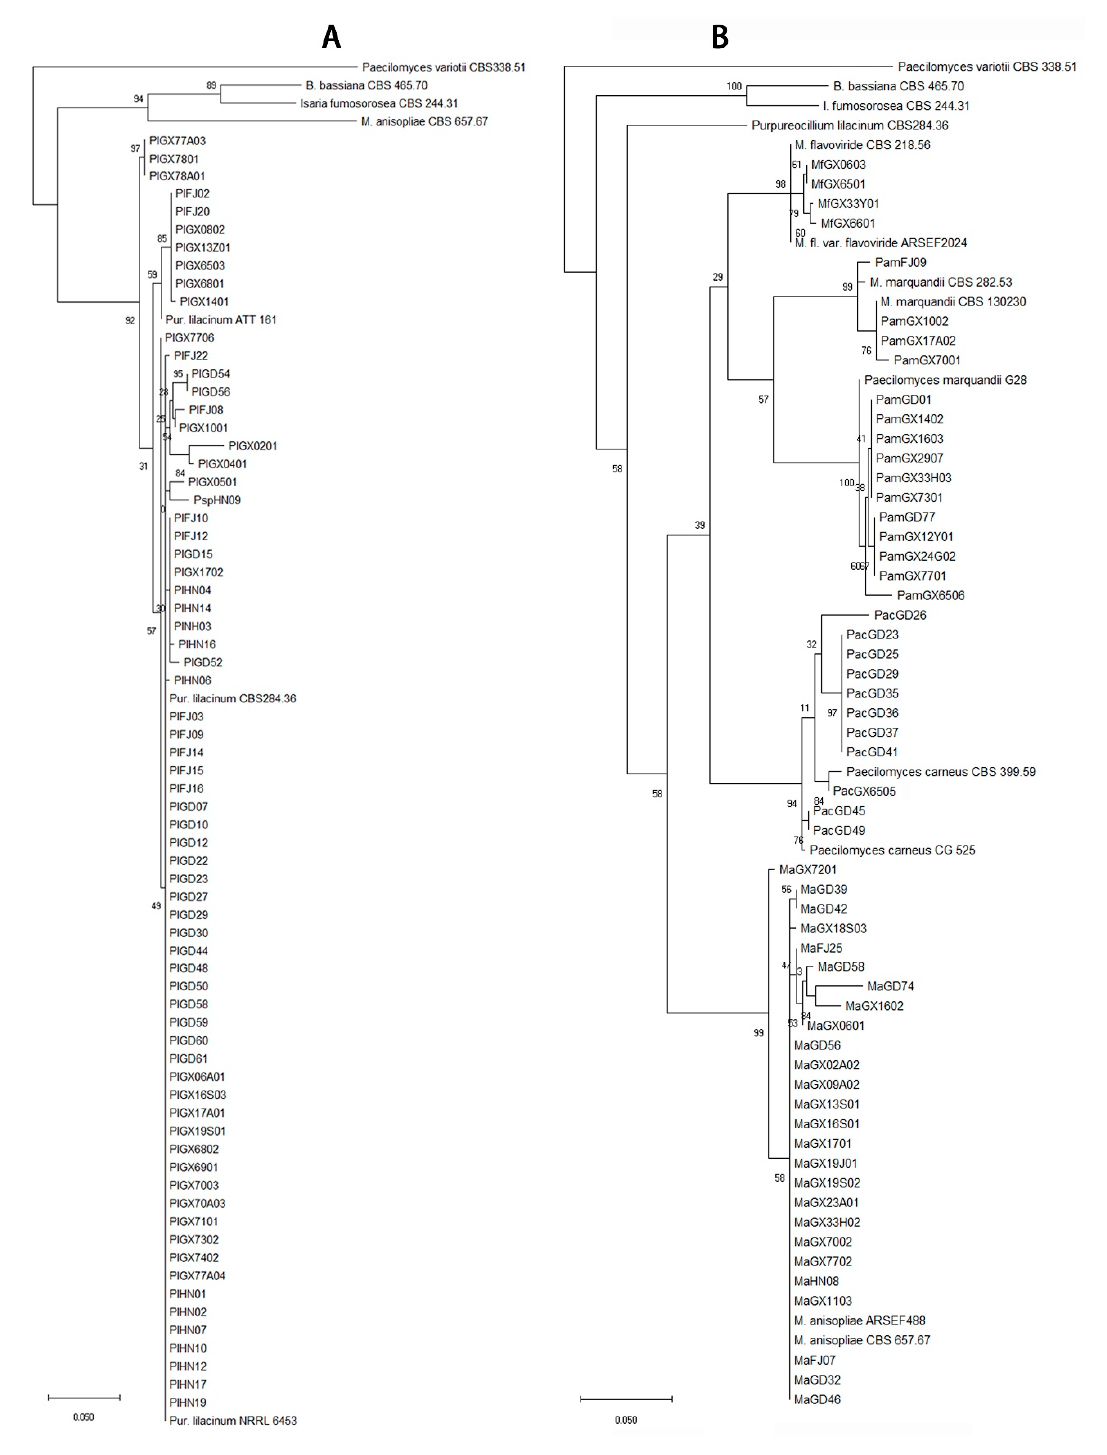
Figure 2. Phylogenetic tree of Purpureocillium spp ( A ) and Metarhizium spp ( B ) isolates.